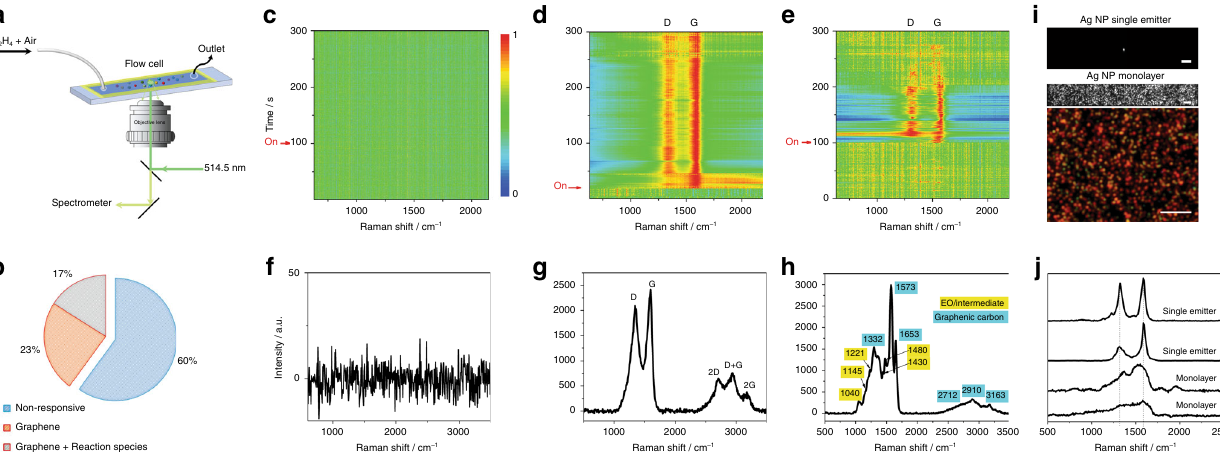
Fig. 1 In situ SERS study of Ag NP-photocatalyzed C 2 H 4 epoxidation. a Schematic of experimental setup, where a home-made reaction fl ow cell is mounted in an optical microscope for in situ SERS study. The SERS monitoring was carried out under the fl ow of C 2 H 4 in air, which serves as the source of oxygen. b Pie chart of activity across 220 Ag NP emitters, showing three classes: non-responsive NP emitters (~60%), those exhibiting graphenic carbon formation (23%), and those showing graphenic carbon formation along with C 2 H 4 oxidation species (17%). A time series of SERS spectra, under photocatalytic reaction conditions, is shown by a waterfall plot for representative cases of c a non-responsive Ag NP emitter, d a Ag NP emitter that shows the formation of only graphenic carbon, and e a Ag NP emitter showing formation of both graphenic carbon and reactive species related to C 2 H 4 oxidation species. Panels c – e share the same color scale and y -axis title. SERS spectra were acquired continuously at a rate of 0.2 s per frame and are shown normalized. The instant when C 2 H 4 fl ow was introduced (and sample refocused) is labeled as on. A representative unnormalized SERS spectrum ( t = 160 s slice, t = 64 s slice, t = 240.2 s slice from water-fall plots in c , d , e , respectively) demonstrates f a non-responsive Ag NP emitter, g presence of graphenic carbon, indicated by SERS peaks associated with D, G, 2D, 2G, and D + G vibrational modes, and h presence of both graphenic carbon and reaction species, respectively. Each key vibrational mode is labeled with the peak wavenumber indicated in cm − 1 . Panels f – h and j share the same y -axis title. i Representative ×60 CCD images of a single laser-excited Ag NP emitter within the spectrograph slit (top, scale bar = 20 μ m) and white light-illuminated wide- fi eld region of a Ag NP monolayer (middle, scale bar = 20 μ m), and a ×100 color camera dark- fi eld scattering image of the Ag NP monolayer (bottom, scale bar = 10 μ m). j Comparison of SERS spectra (single time-slice) obtained from a single Ag NP emitter (two representative cases) with those from a Ag NP monolayer (two representative cases), demonstrating the necessity for single-emitter-level spectroscopy. Spectra are shown